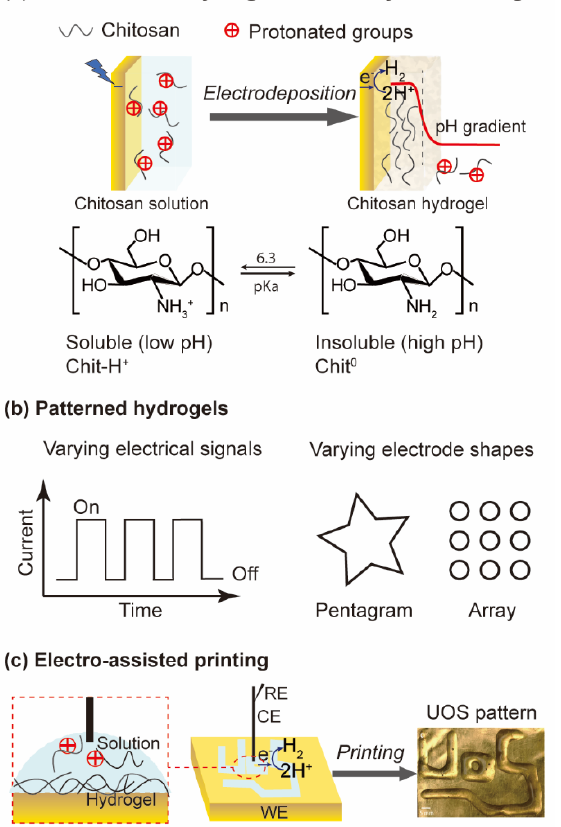
Figure 3. Electrofabrication of electrode-based chitosan hydrogels. ( a ) Chitosan-based hydrogels induced by electrical signals. ( b ) Patterned hydrogels formed by varying electrical signals or electrode shapes. ( c ) Electro-assisted printing of chitosan hydrogels. Adapted with permission from ref [33]. Copyright (2022) Springer Nature.